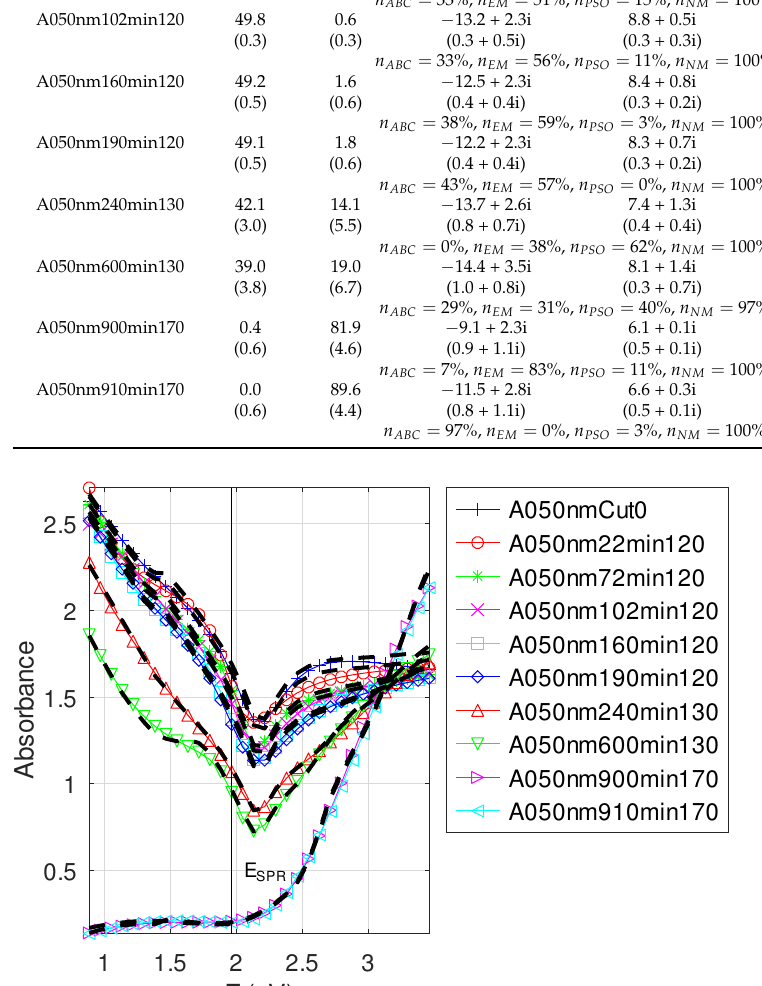
Figure A11. Absorbance as a function of the photon energy: experimental (black dashed) and best calculated solution (color) for each oxidized sample (initial thickness h 0